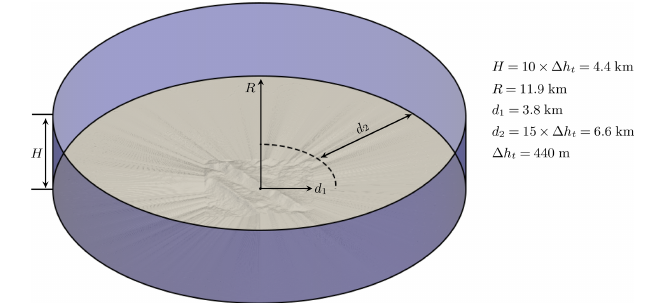
Figure 3. Computational domain; (cid:49)h t is the difference in the ele- vation height of the terrain.